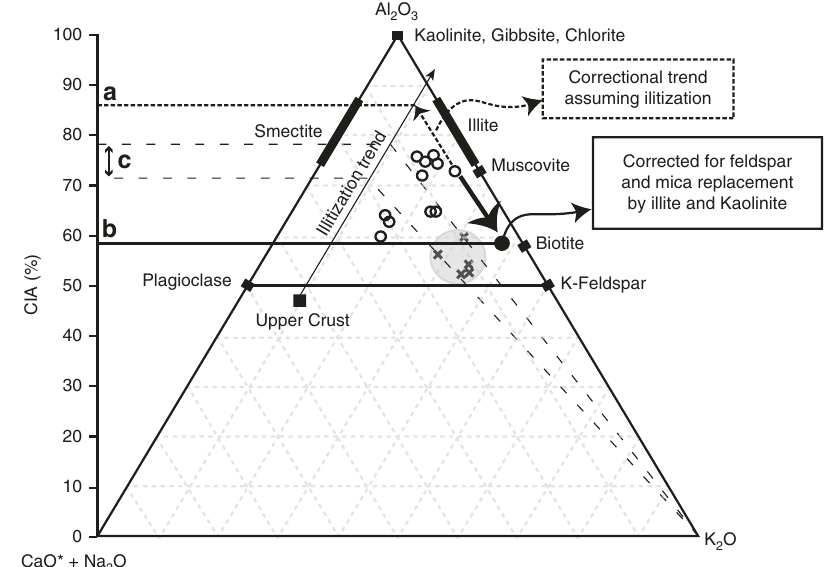
Fig. 6 CIA ternary diagram plotting 11 samples (un fi lled circles) range between 61 and 78% from laminated mudstones in the Urapunga 4 core. Elemental data from XRF analysis. Correction of CIA for K-metasomatism (illitization) 48 following the dashed line ( a ) from the average upper crust value (black square) identi fi es a range of CIA values for these same samples up to 87%. Data from Tosca et al. 36 (crosses) show a lower range of values between 51 and 61% that were corrected to 72 – 78% ( c ). The sample with highest corrected CIA value (from 107 m depth) was used to evaluate the effects of replacement and authigenic clay formation (Fig. 3). The CIA value for the restored detrital composition from Fig. 3c ( fi lled circle) shows a lower CIA value ( b ) resulting from the addition of kaolinite and illite as replacement of biotite and feldspar. Average upper Archean upper crust composition identi fi ed by Condie et al. 62 and adapted by Tosca et al. 36 for correction for metasomatism